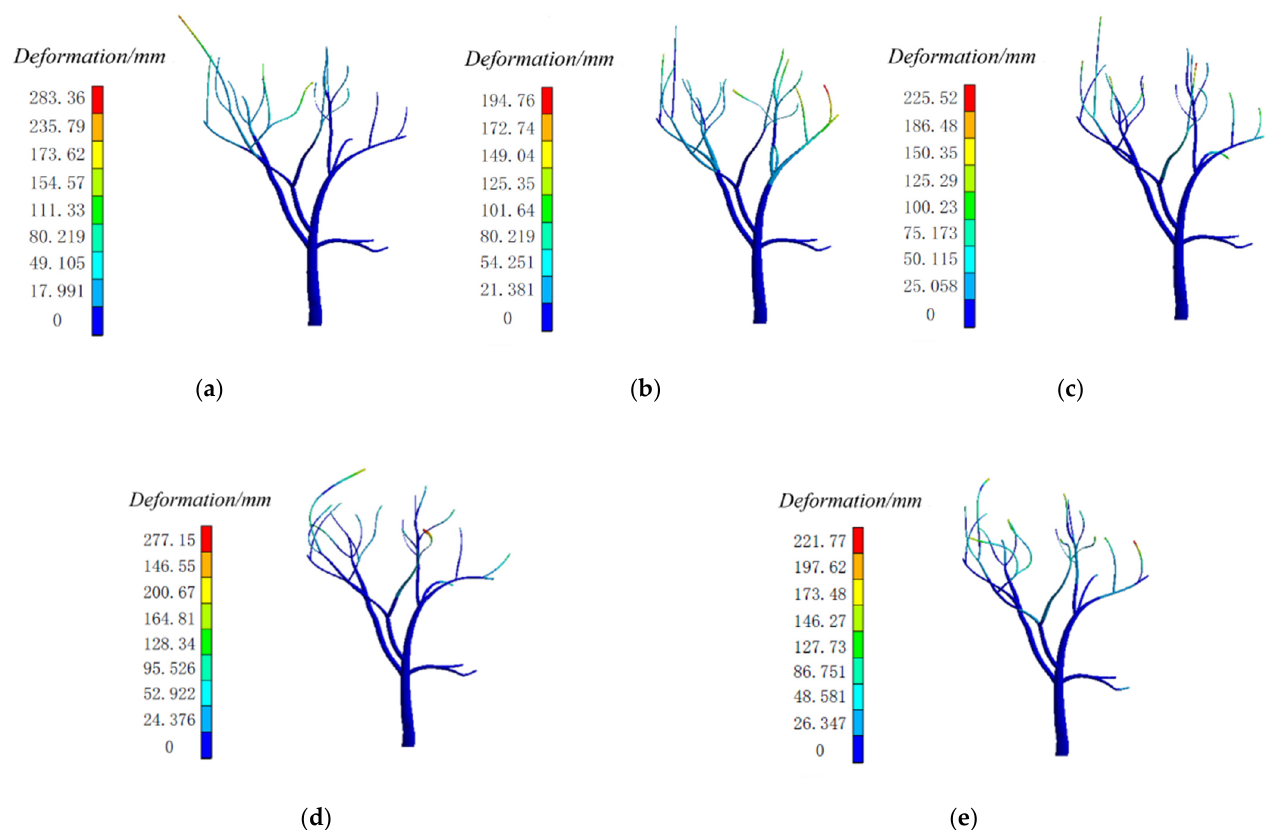
Figure 7. Model of free-response cloud image comparison. ( a ) Response cloud map representing point A of typical displacement feature; ( b ) Response cloud map representing point B of typical displacement feature; ( c ) Response cloud map representing point C of typical displacement feature; ( d ) Response cloud map representing point D of typical displacement feature; ( e ) Response cloud map representing point E of typical displacement feature.